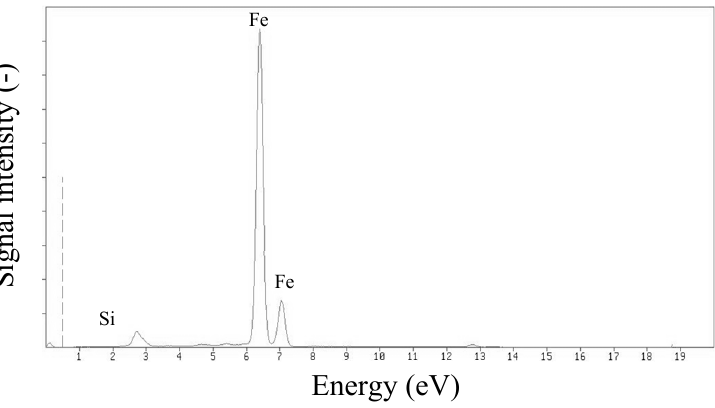
Figure 16. X-ray fluorescence (XRF) spectrum of Fe 3 O 4 @SiO 2 @VIN@MIP.